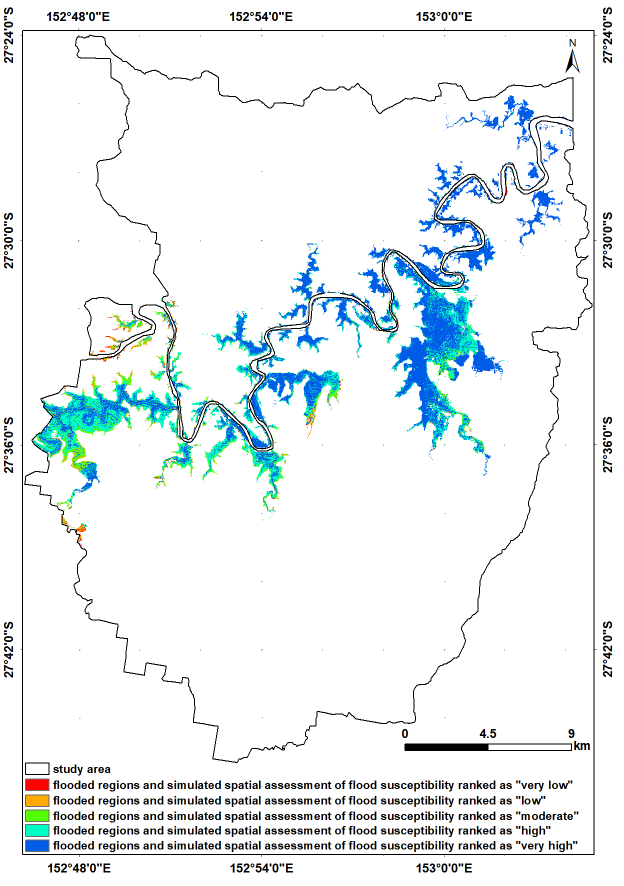
Figure 12. Comparison of flooded region by hazard map and simulated spatial assessment of flood susceptibility ranked by each class using PSO-DLNN.